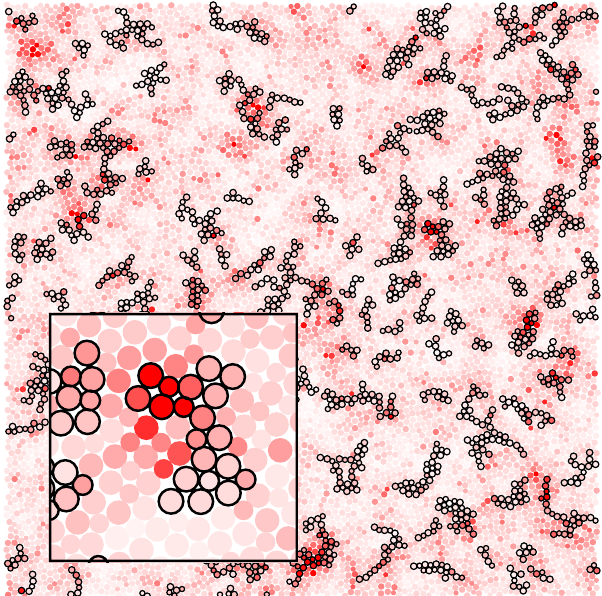
FIG. 1. An example configuration of the system at T ¼ 0 . 1 and _ γ ¼ 10 − 4 . Particles are colored according to their D 2 text). Particles outlined in black are members of the soft spots for this configuration. The soft spots have been generated using ¼ 430 and N ¼ 20 . Inset: A single soft spot coinciding with N m p a